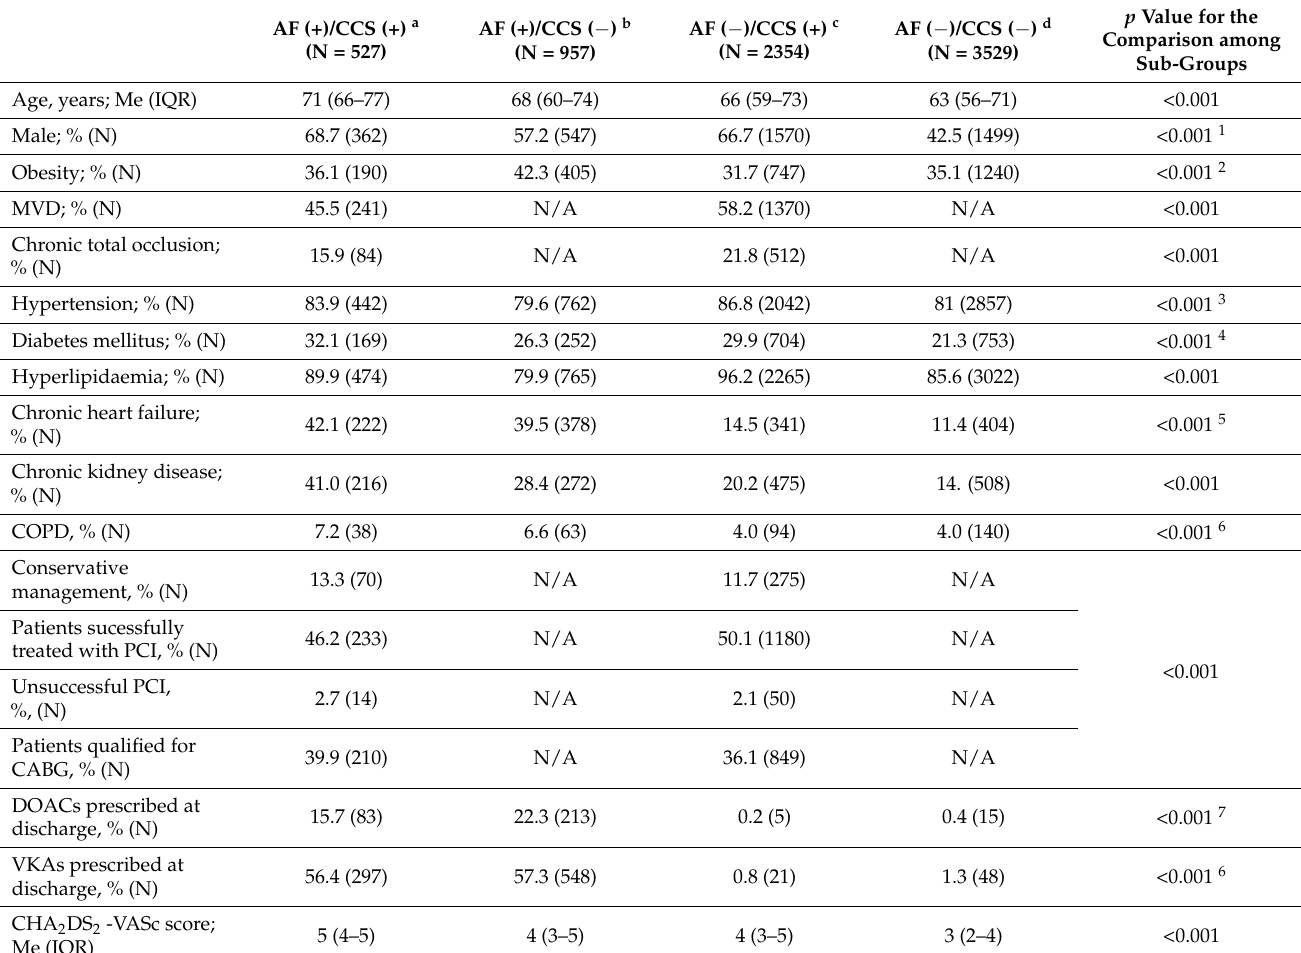
Table 2. Differences in the characteristic of study participants according to the presence of atrial fibrillation and obstructive chronic coronary